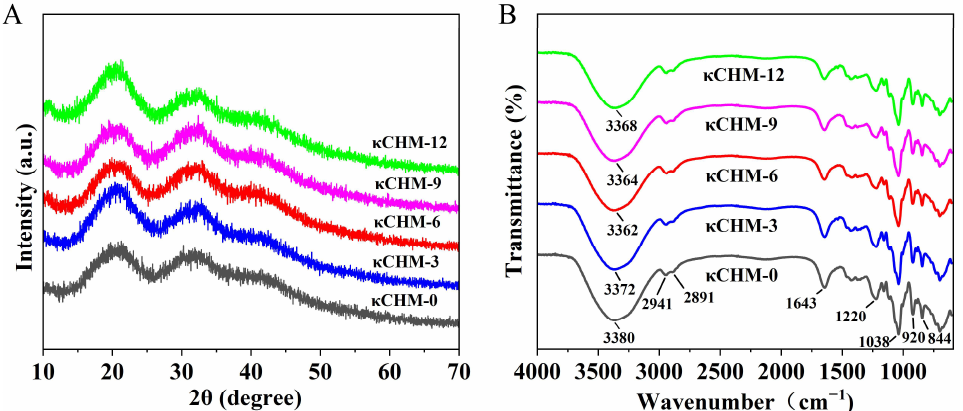
Figure 4. ( A ) XRD pattern and ( B ) ATR-FTIR spectrum of κ CHM films. XRD, X-ray diffraction analysis; ATR-FTIR, attenuated total reflection–Fourier transform infrared spectroscopy.